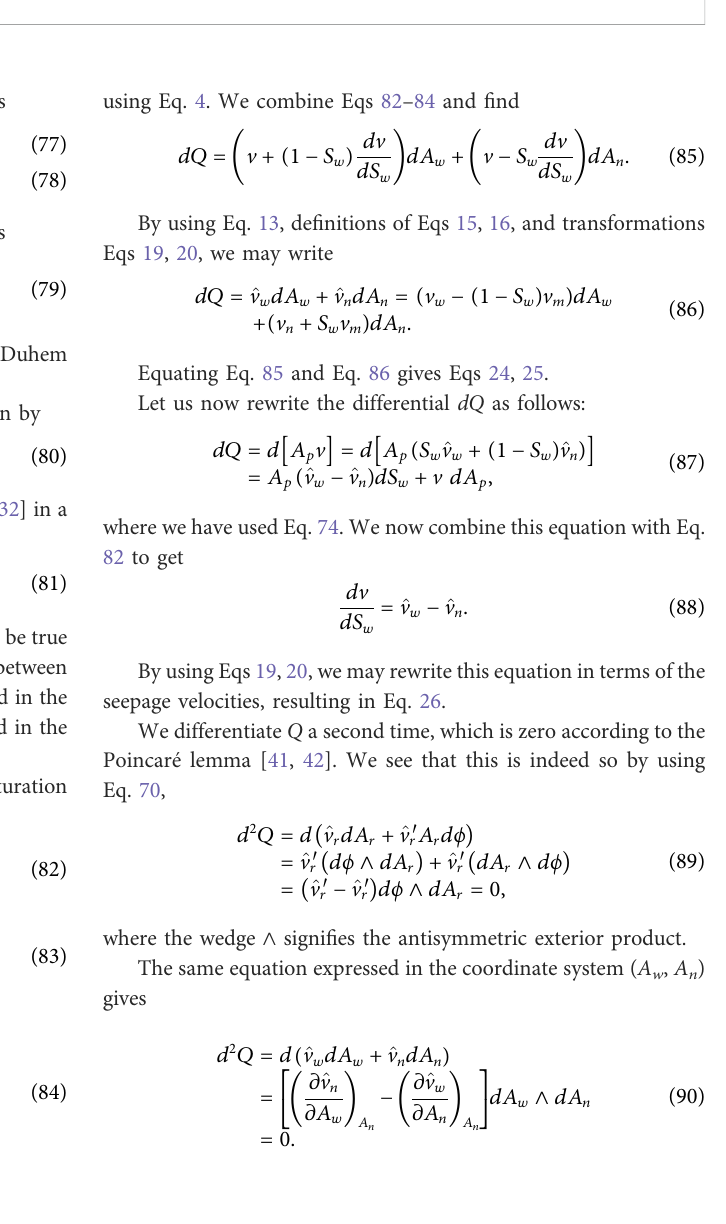
FIGURE 4 Vectorial representation for eqs. 52, 58, where A r (cid:2) | (cid:1) A | is illustrated. The difference in the vectors detected by the properties of (cid:1) A